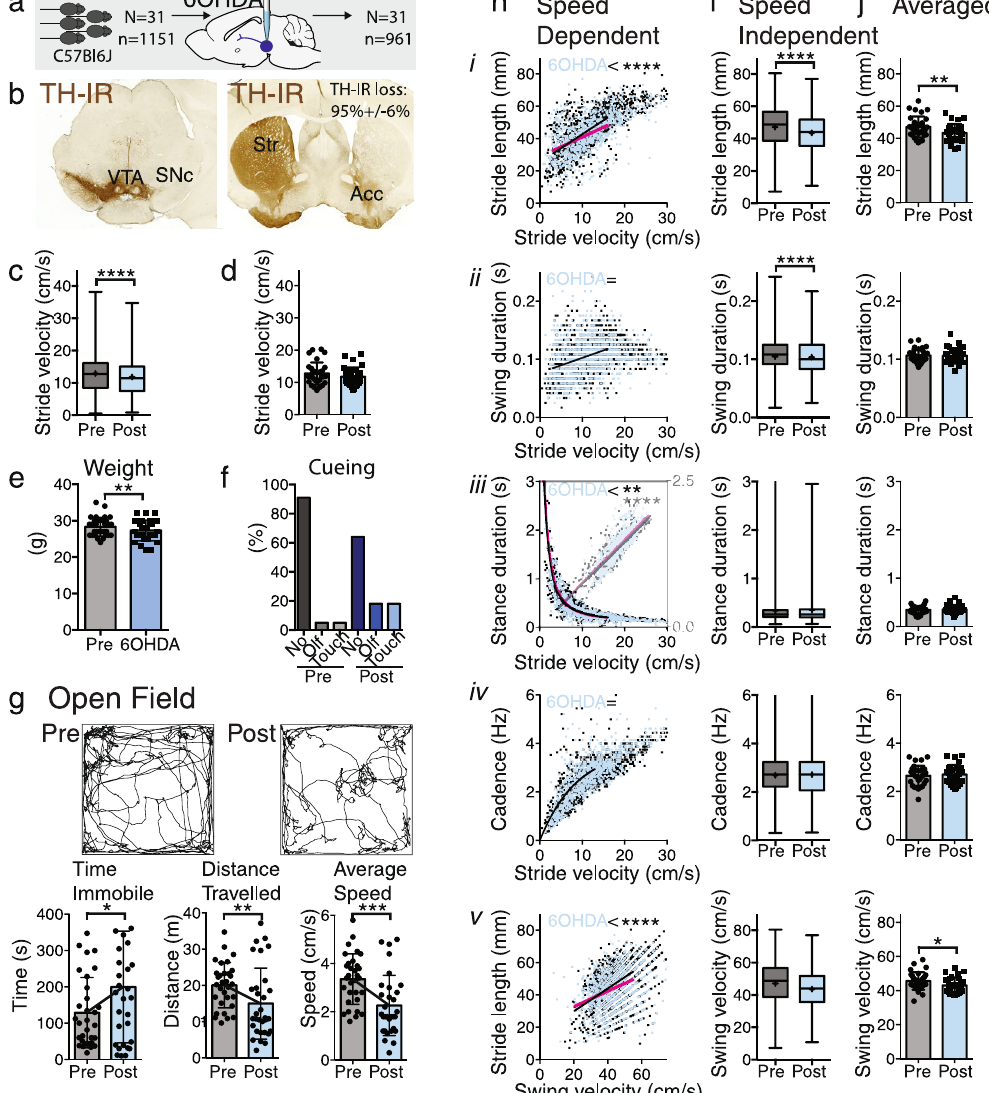
Figure 4. Effects of 6-OHDA treatment on gait. ( a ) In 31 C57Bl6 mice gait and locomotor activity was studied before and after unilateral 6-OHDA injections into the substantia nigra. ( b ) Intranigral 6-OHDA induced unilateral loss of tyrosine-hydroxylase immunoreactivity in the ipsilateral striatum. ( c and d ) Velocity was significantly lower post 6-OHDA as determined by stride-to-stride data (Mann Whitney Rank test; Supplementary Table S3), but this was not detected in the averaged data sets (2-tailed paired t-test). ( e ) Three weeks following 6-OHDA, mice had lost weight (paired, 2-tailed t-test). ( f ) When collecting gait data, cueing was used in 40% of the trials. ( g ) Overall locomotor activity in the open field test was significantly reduced and animals spent more time immobile (paired, 2-tailed t-test; Supplementary Table S3). ( h ) Relationships of stride length ( i ), swing duration ( ii ), stance duration ( iii ), cadence ( iv ) as a function of stride velocity and stride length as a function of swing speed ( v ). The fit of one curve to both data sets was compared with the fit of individual curves fit to each dataset. Stride length and stride length as a function of swing speed showed highly significant differences (F test; Supplementary Table S3). ( i ) The distribution of stride-to-stride data showed significant differences for stride length ( i ) and swing duration ( ii ). However, these are difficult to interpret due to changes in velocity in stride-to-stride data sets (Mann Whitney Rank test; Supplementary Table S3). ( j ) Averaged data sets revealed decreased stride length ( i ) as a function of velocity or swing duration ( ii ), but no changes in other gait parameters ( iii-v ; paired 2 tailed t-test; Supplementary Table S3). Asterisks indicate level of